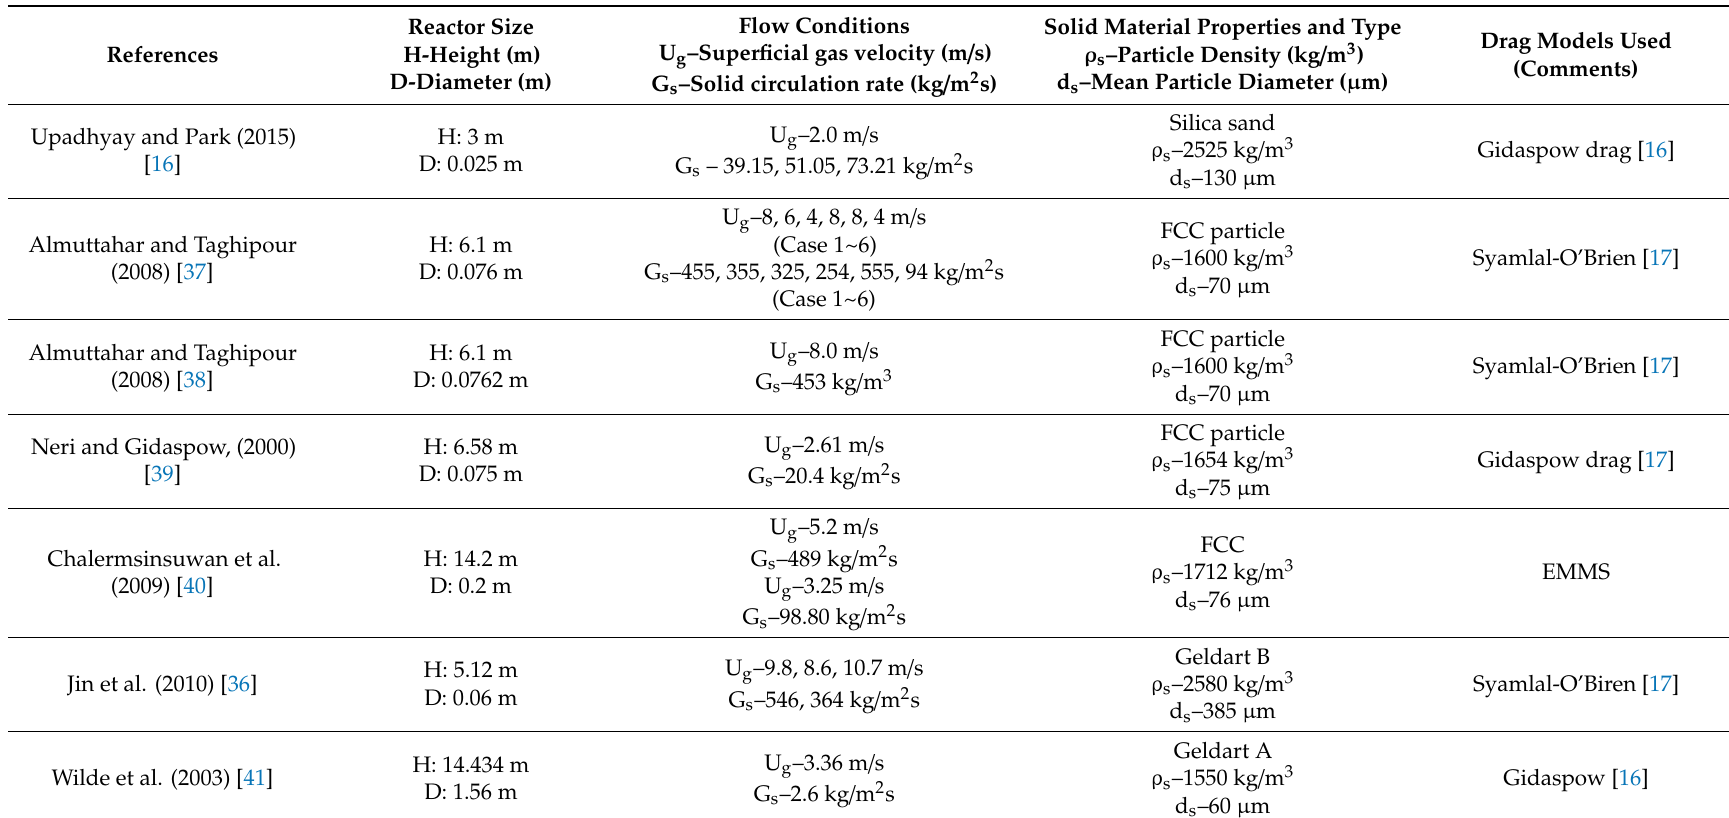
Table A1. Gas–solid drag models used in